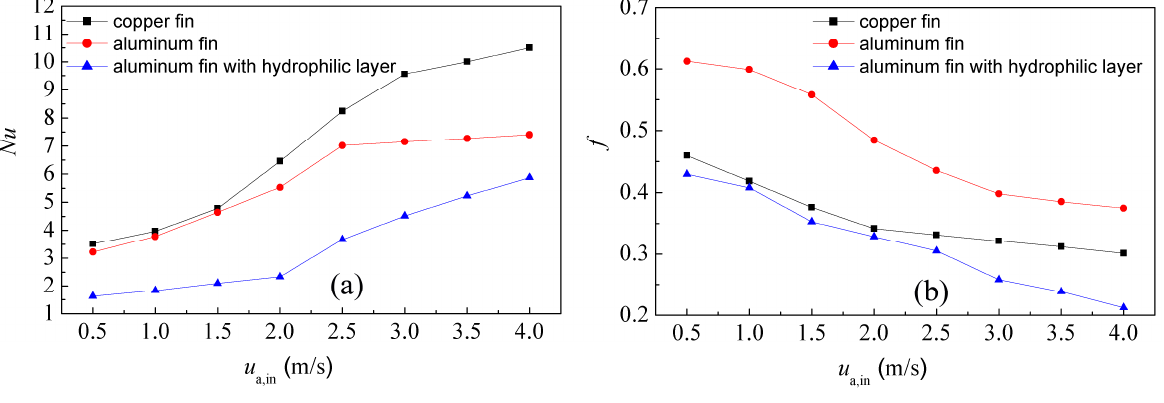
Figure 11. Effect of u a,in on Nu and f : ( a ) Nu , ( b ) f .